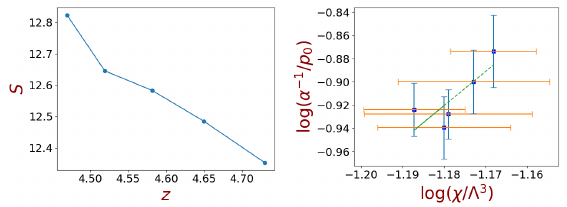
Figure 4: Entropy per grain as a function of the average number of contacts of the sample, Eq. (13) (left). Relation between the two terms in the proposed equation of state (Eq. 14) (right). The slope in the linear fit is 2 . 94 ± 1 .